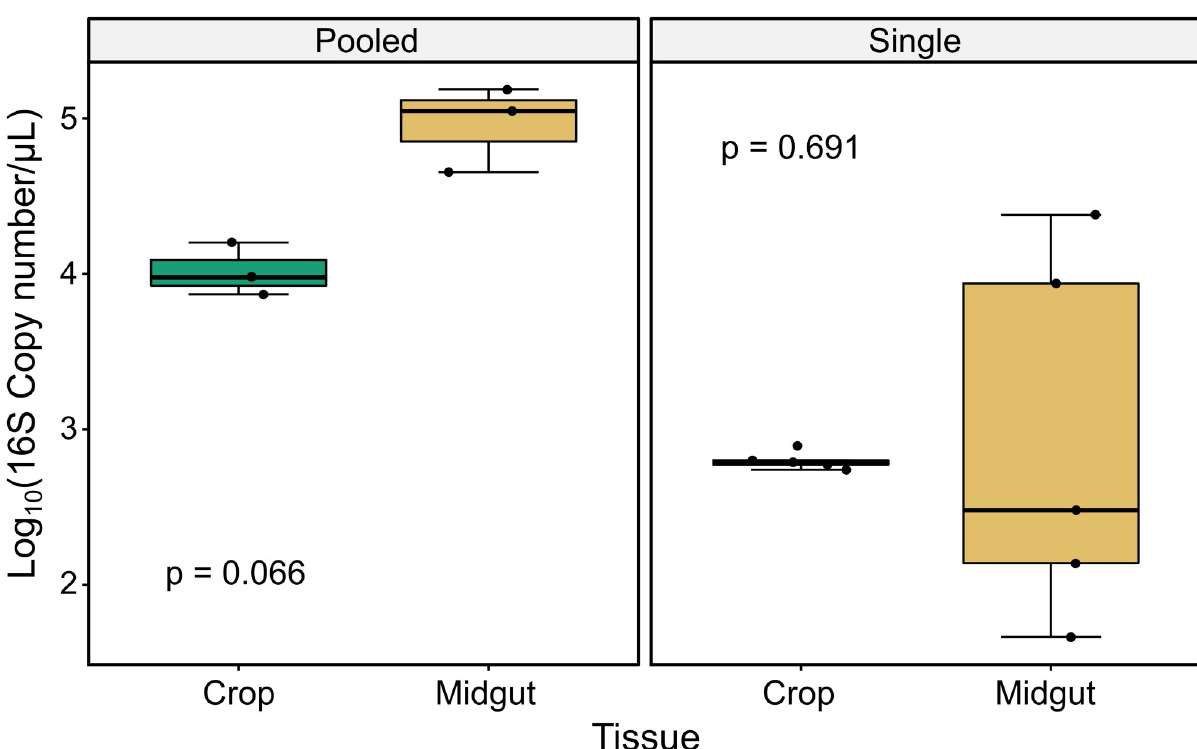
Fig 1. Microbiota size measured using qPCR is more variable in midguts compared to crops. We measured copy number of the 16S bacterial rRNA gene using qPCR. Samples were either pooled (left panel) in groups of 8 (n = 3 pools per tissue type) or assayed as individual single tissues (right panel) (n = 5 samples per tissue type). For pooled samples, variance was similar between tissues (Levene’s test for equal variances: F = 0.256, p = 0.640), but for single samples the variance among midgut samples was significantly larger than crop samples (Levene’s test for equal variance, F = 6.12, p = 0.038). For pooled samples, median log 10 (16S copy number/ μ l) trended higher in midguts (median = 5.05) than in crop samples (median = 3.98) though the difference between tissues was not significant using a paired t-test (t = 3.69, p = 0.066). For single samples, median values were similar for midguts (median = 2.48) and crops (median = 2.79) and were not significantly different using a Wilcoxon rank sum test (p = 0.691).